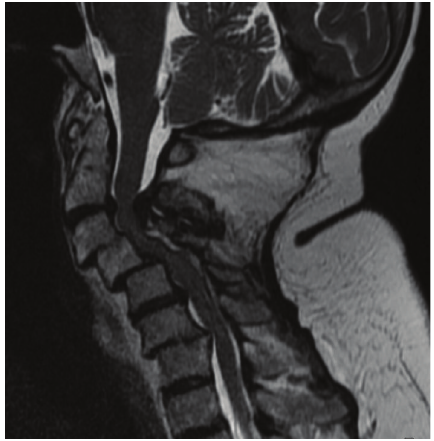
Figure 4: Sagittal MRI scan demonstrating the subaxial “staircase” deformity and significant posterior ligamentous hypertrophy con- tributing to cervical